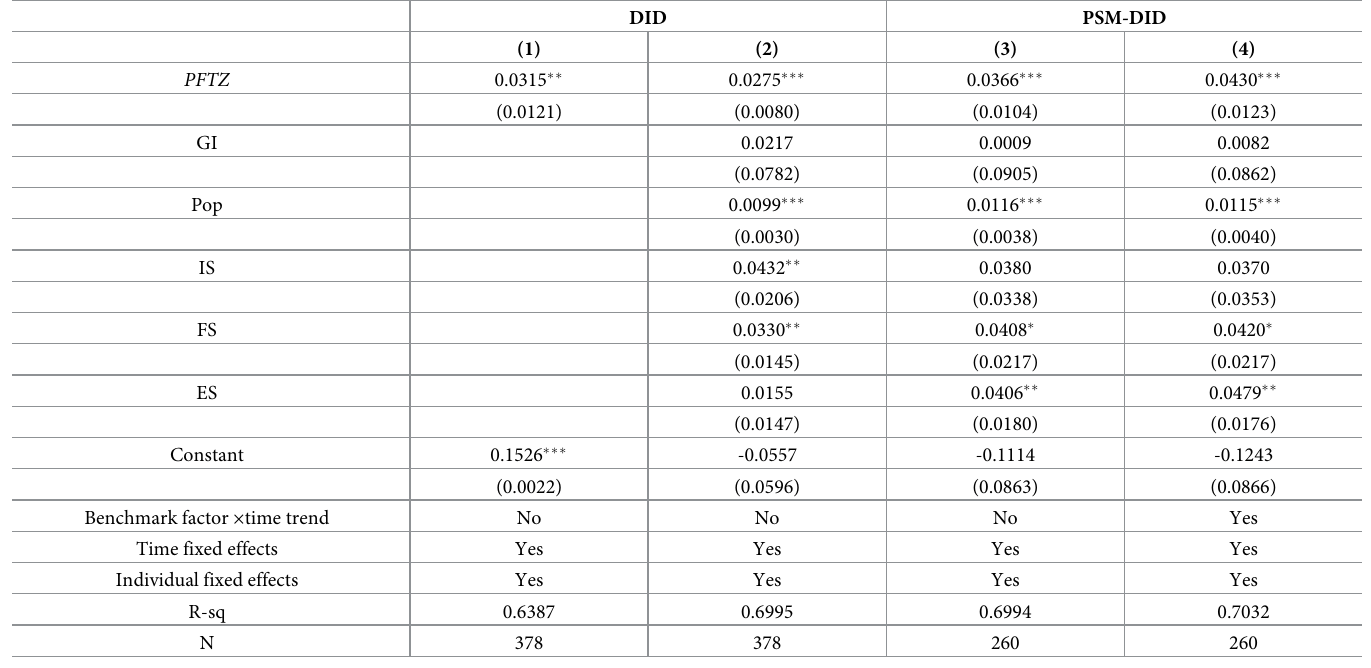
Table 5. Regression